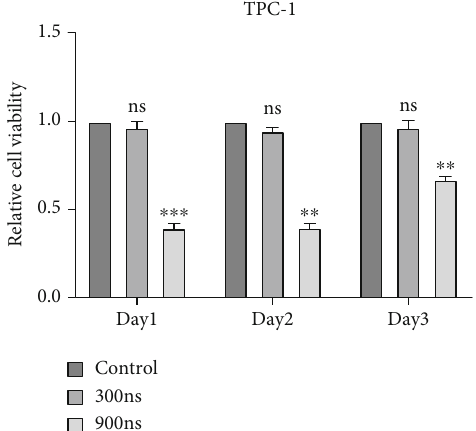
Figure 2: NsPEFs decreased the cell viability of TPC-1 cells. TPC-1 cells were treated with pulsed electric fi elds of 0 ns, 300ns, and 900 ns pulse duration. Then, CCK-8 was used to analyze the e ff ect of nsPEFs on the viability of TPC-1 cells. ∗ p < 0 : 05 ; ∗∗ p < 0 : 01 ; ∗∗∗ p < 0 : 001